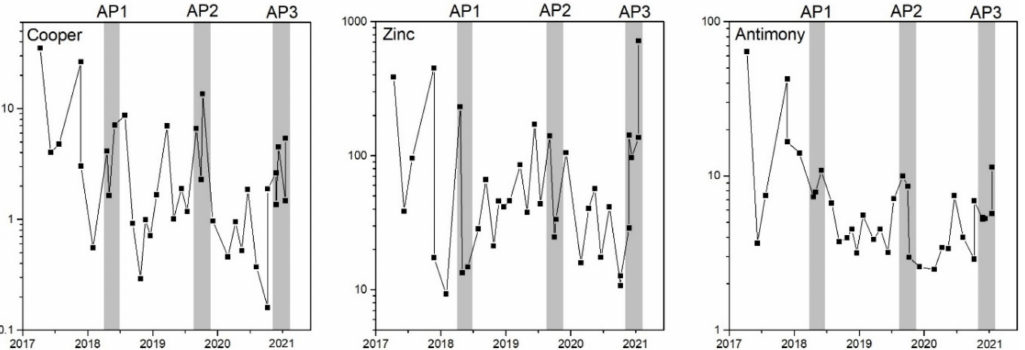
Figure 4. Variations in the concentration (in ppb) of representative chalcophile elements. Grey areas represent anomalous periods (AP) described in Section 4.2.